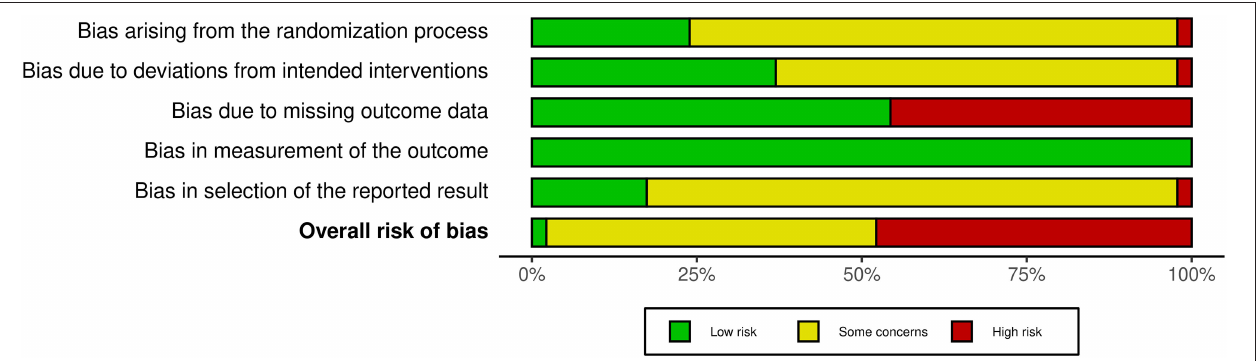
FIGURE 2 | Summary of the distributions of the reviewers’ judgements across the studies for each risk of bias domain.